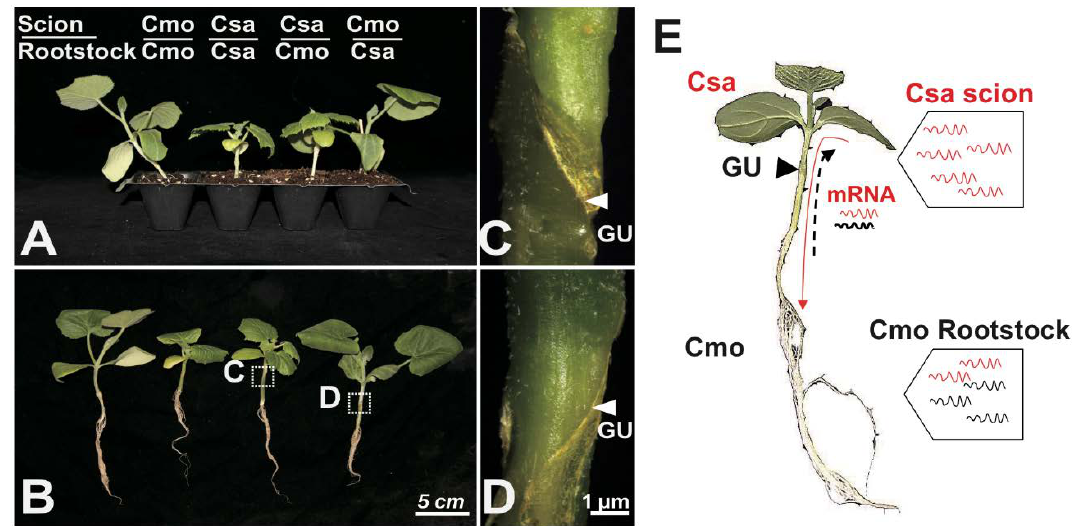
Figure 1. Hypocotyl grafting of Cucumis sativus and Cucurbitea moschata seedlings. ( A ) Cucumis sativus (scion) / Cucurbitea moschata (rootstock) (Csa / Cmo) and reverse grafting (Cmo / Csa) heterograft combinations and homografts (Csa / Csa, Cmo / Cmo). Csa and Cmo seedlings of the same size were used for hypocotyl grafting. Grafting was performed when Csa seedlings were approximately 2 cm in diameter with the first true leaf; Cmo seedling carried flattened cotyledons and were 1 cm diameter with first true leaf. The graft junction was healing seven days after grafting. ( B ) Growth of seedlings from four grafting combinations. The whole first true leaf with petiole and whole root of all grafts were harvested for further RNA-seq determination. To avoid individual bias, each graft combination included 8–9 individual grafted plants. Graft-union magnification of ( C ) Csa / Cmo and ( D ) Cmo / Csa seedlings shown in ( B ); arrowheads indicate graft union (GU). ( E ). Scion-to-rootstock long-distance movement of heterologous mRNAs through the phloem was identified in hypocotyl-grafted cucurbits. If Csa transcripts (red) moved to Cmo stock across the grafting union, they could be distinguished from Cmo transcripts (black) based on genomic single nucleotide polymorphism (SNP) differences. The first true leaf and whole root were sampled for further analyses. Dotted arrow indicates rootstock-to-scion mobile Cmo transcripts (black) moving to Csa through cell-to-cell spread or a cycle pathway of scion-to-rootstock-to-scion.